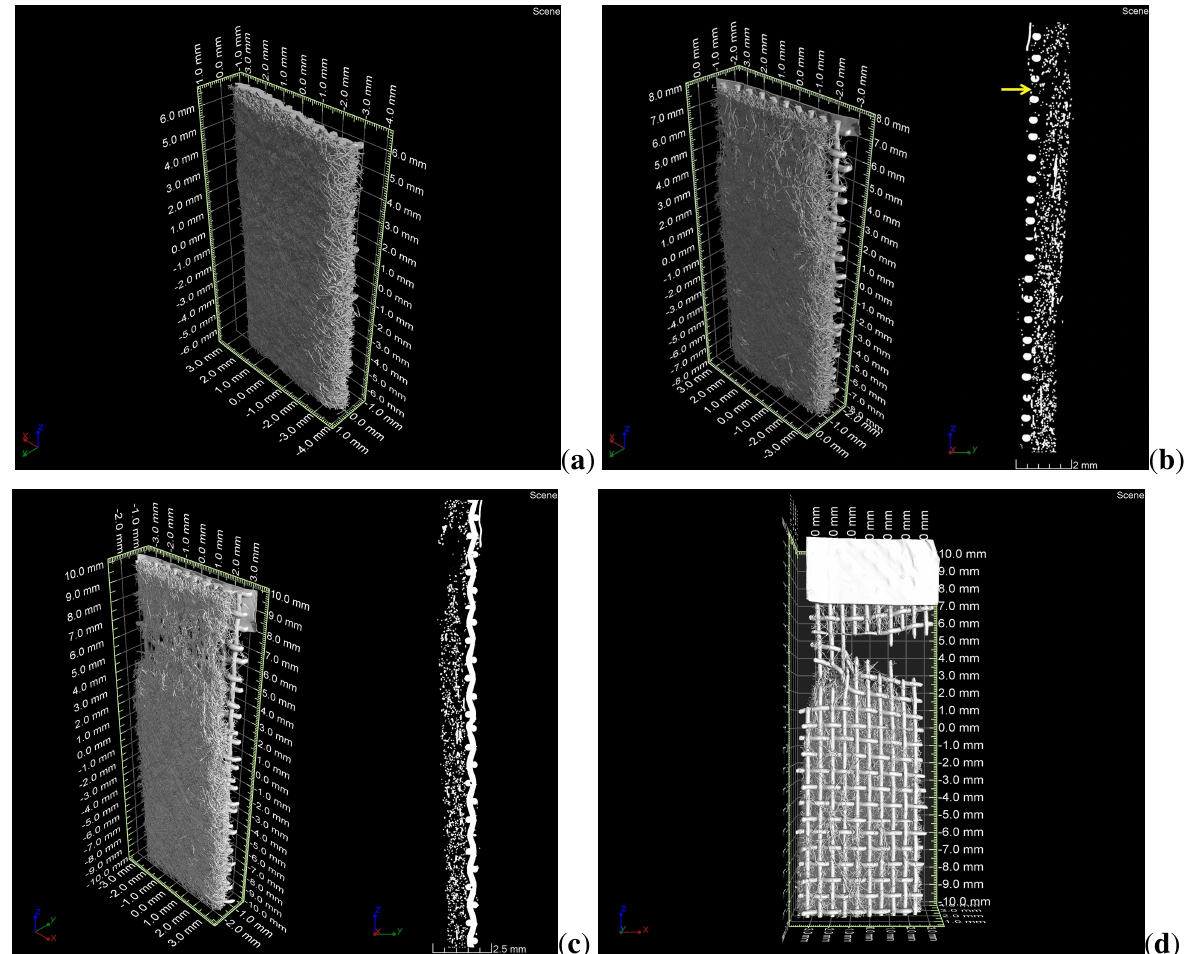
Figure 5. CT images of the SFF 100 tensile test sample. ( a ) three dimensional view before tensile tests; ( b ) three dimensional view and sectional view of the y-z-plane oriented parallel to the direction of loading after (cid:15) = 17% ; ( c ) three dimensional view after (cid:15) = 27% ; ( d ) three dimensional view of the support grid after (cid:15) = 37%